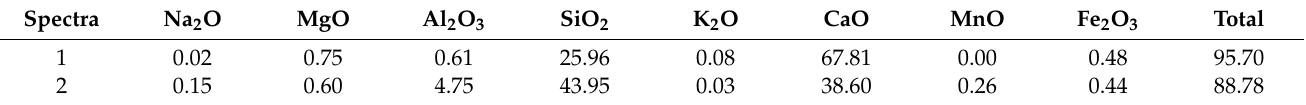
Table 5. Results of the typical microphases analysis (images of the analysis are in the Figure